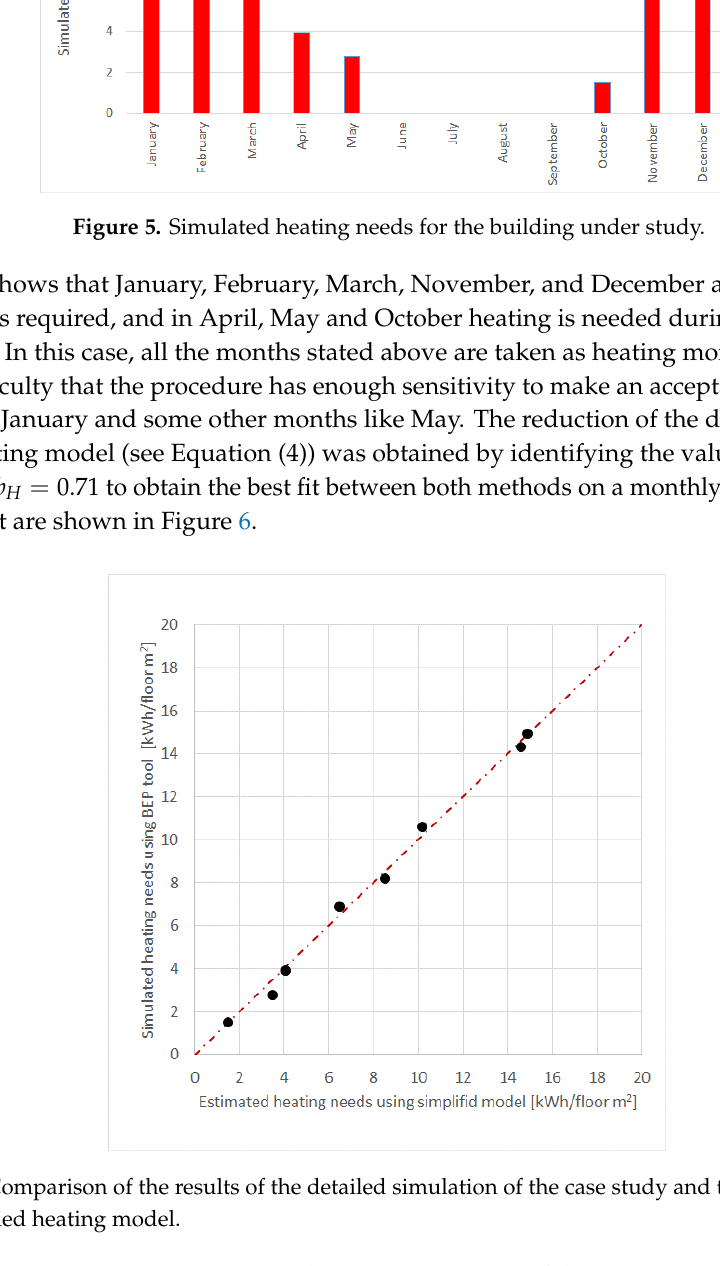
the simplified heating model.